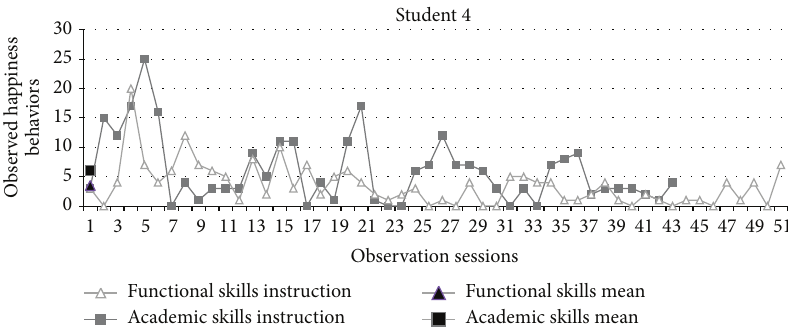
Figure 5: Total frequency of behaviors associated with happiness per observation session for Student